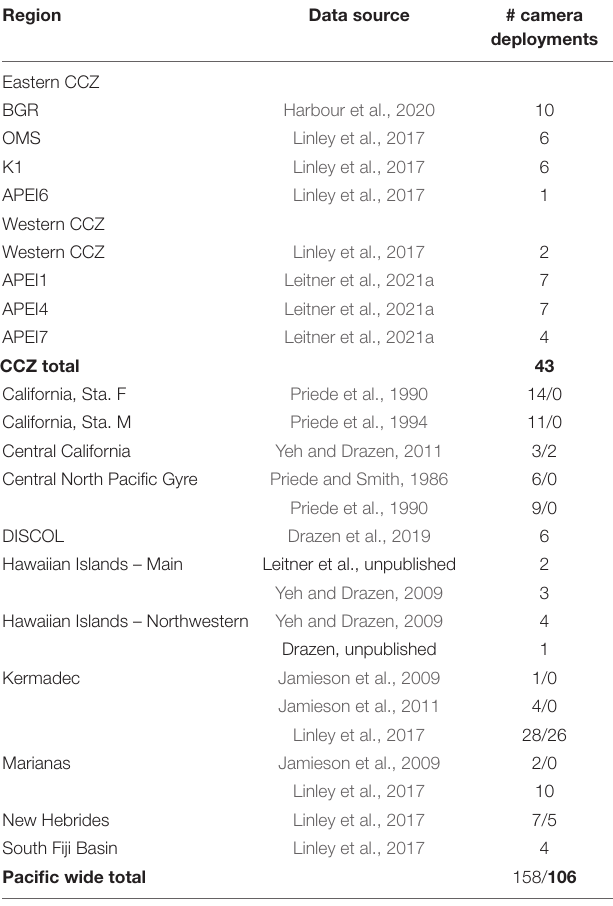
TABLE 2 | Summary of available published and unpublished baited camera datasets from across the Pacific Ocean between 3,000–6,000 m depth (abyssal) by region and data